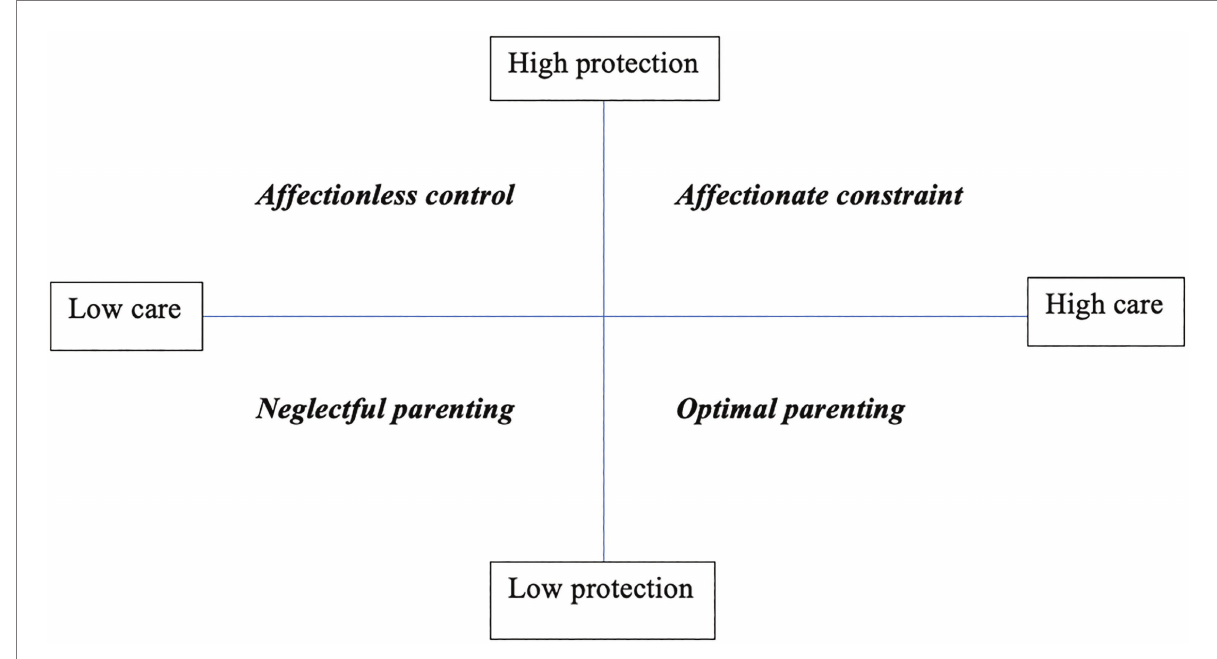
FIGURE 1 Parenting styles based on the combination of the dimensions “care” and “protection” (Parker et al.,